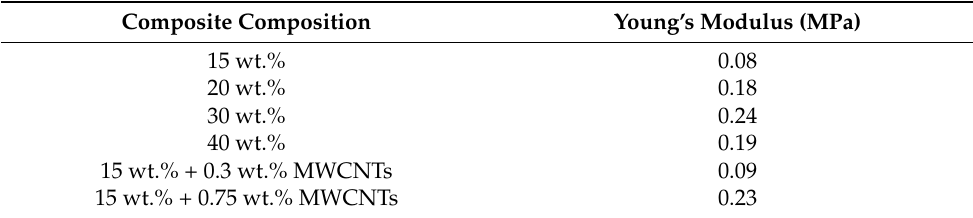
Table 2. Young’s modulus for different composites. Composite